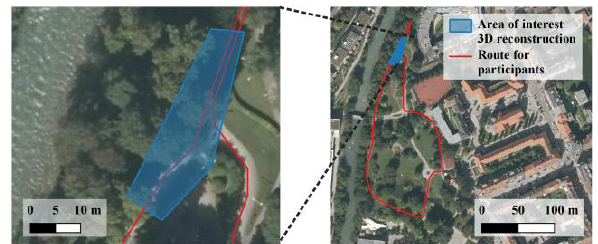
Figure 2. Study site with entire route for participants of the study and sub-area for 3D reconstruction of